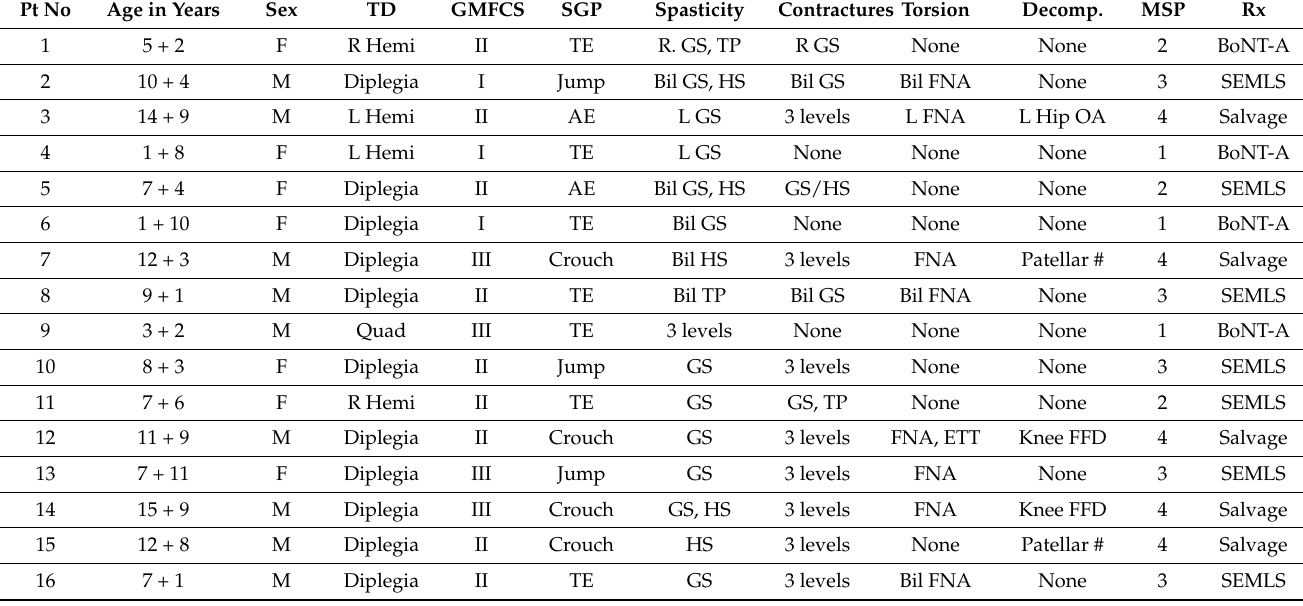
Table 2. Summary of patient data, for the 16 patients in the reliability